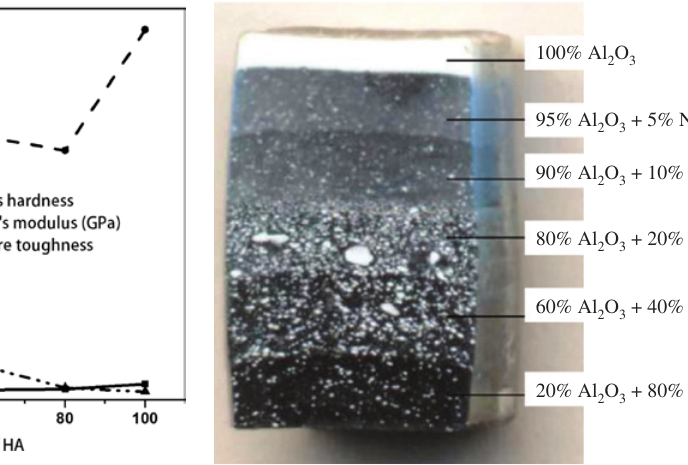
O -Ni FGM having layers with different 2 3